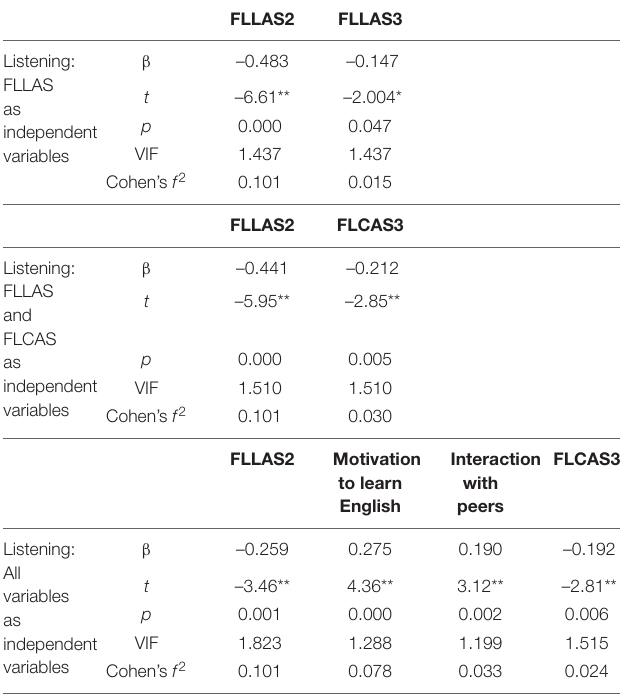
TABLE 7 | Multiple regression coefficients and significance of predictors for listening English proficiency (phase 2). FLLAS2